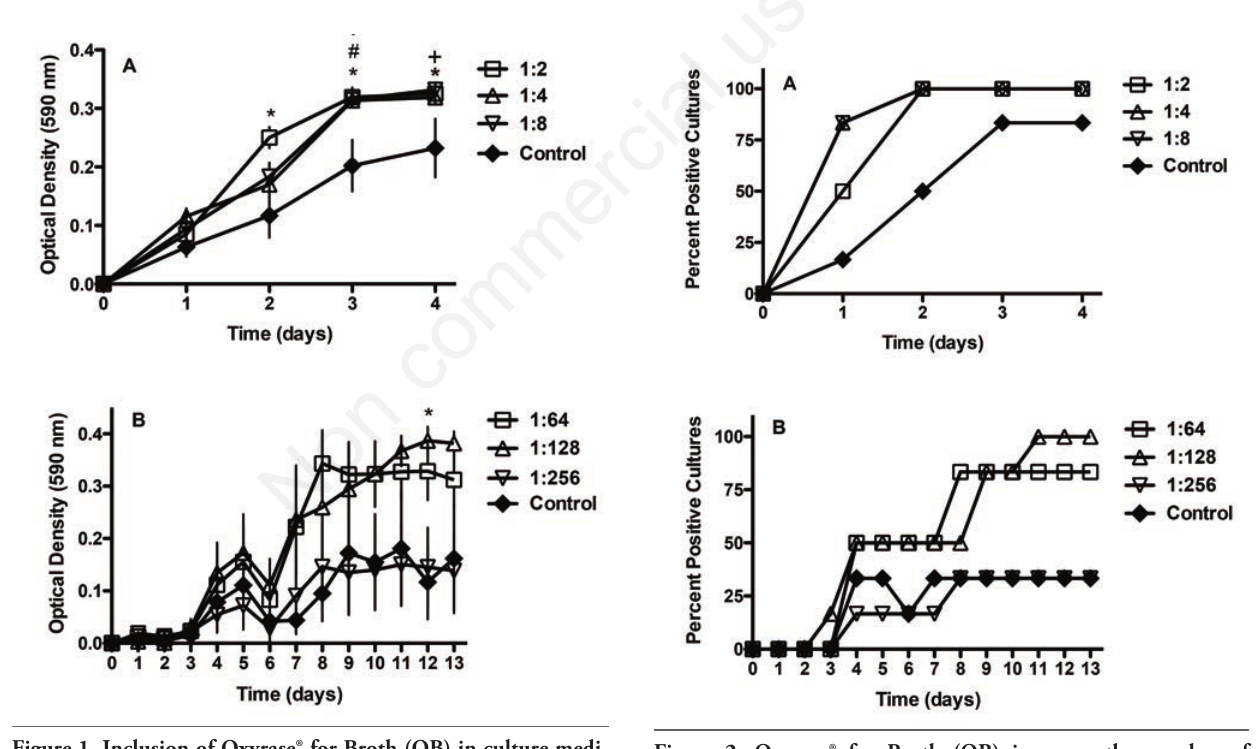
Figure 2. Oxyrase® for Broth (OB) increases the number of Mycobacterium smegmatis (MS) cultures that recover from dor- mancy. The optical density (590 nm) of MS grown in LB broth containing serial dilutions of OB was measured until growth ceased or contamination was observed. Wells were regarded pos- units itive if the optical density was greater than 0.085 OD 590 greater than the plate average at day 0. Only the dilutions of OB that affected MS growth are shown. A) Experiment 1. B) Experiment